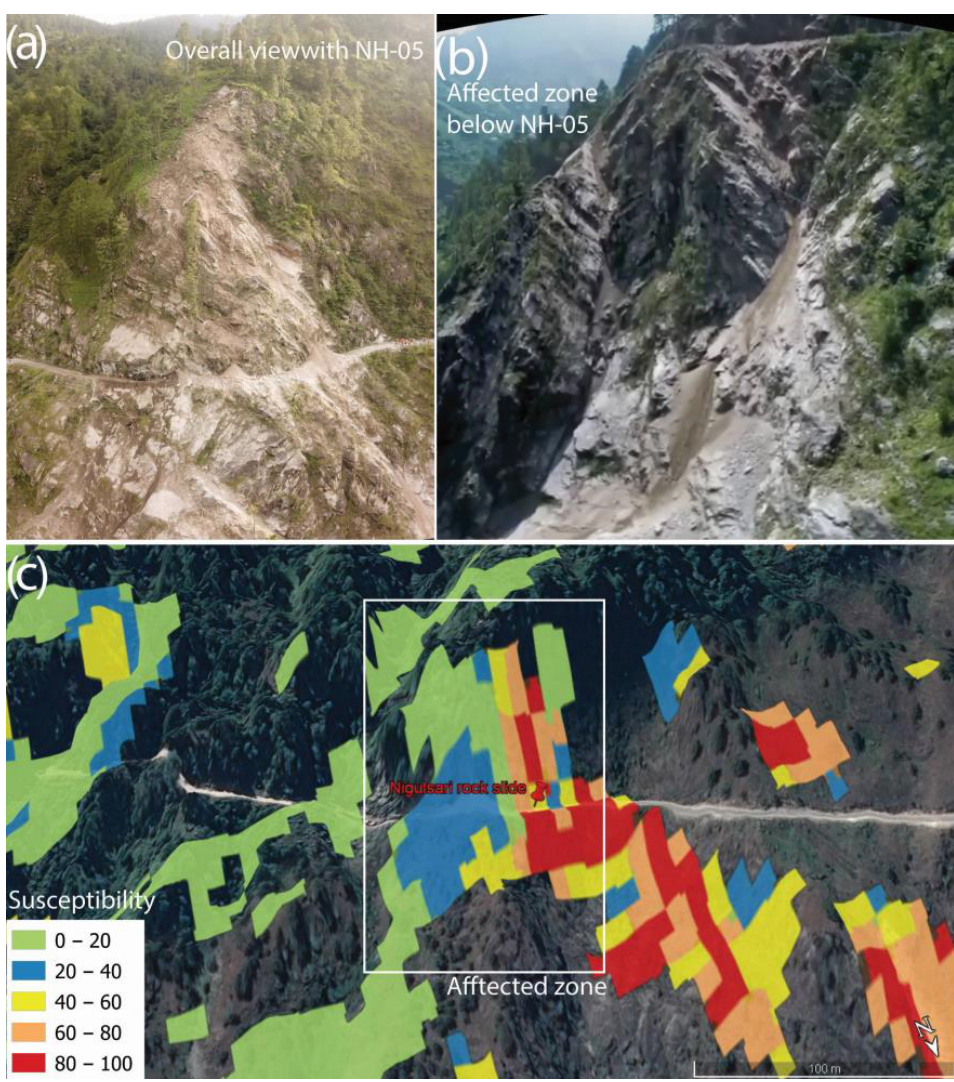
Figure 14. ( a ) Kinematic susceptibility map draped over Google Earth (GE) view showing locations of Nigulsari and Jeori landslide; ( b ) GE image before occurrence of Jeori landslide; ( c ) GE image post failure clearly shows signs of disturbance; ( d ) Susceptibility map overlain on GE view shows the zone is highly to very-highly susceptible to kinematic failure.